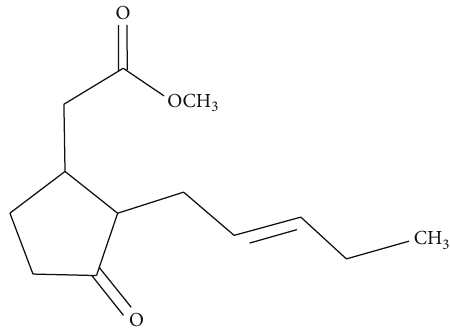
Figure 1: Chemical structure of methyl jasmonate (cyclopen- taneaceticacid, 3-oxo-2-(2-penten-1-yl)-, methyl